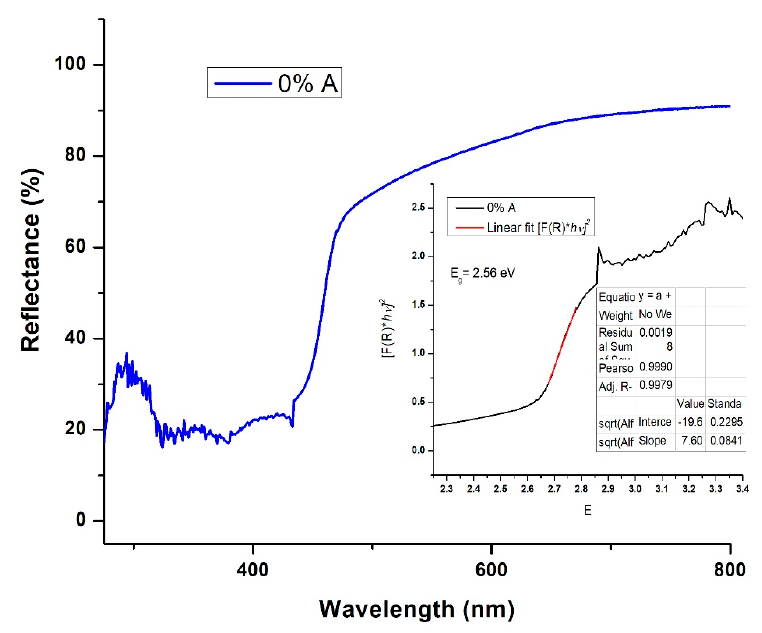
Figure 6. Reflectance spectrum for a sample containing 0% anatase.